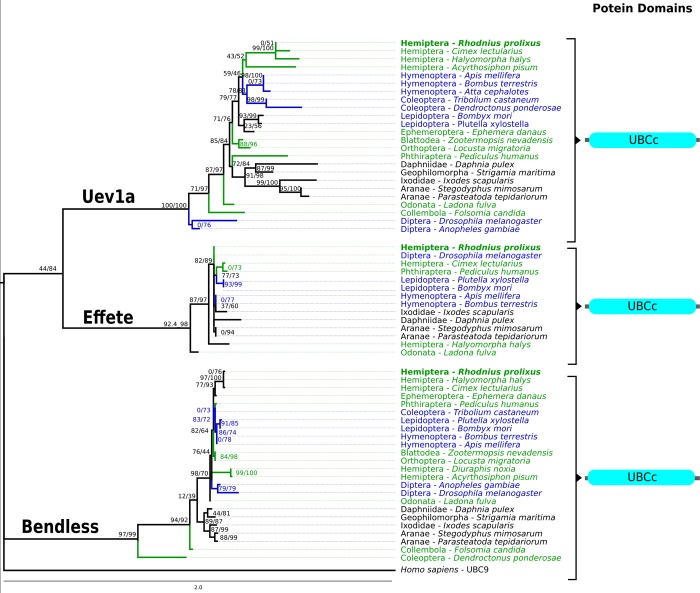
Uev1a, Effete, and Bendless Maximum likelihood phylogenetic trees in selected arthropods.These ubiquitin conjugating enzymes share an UBCc domain that constitutes most of their structure. Orthologs of each of these proteins are contained in a single clade separate from the other protein clades. The human UBC9 was used as outgroup to build the ML trees.